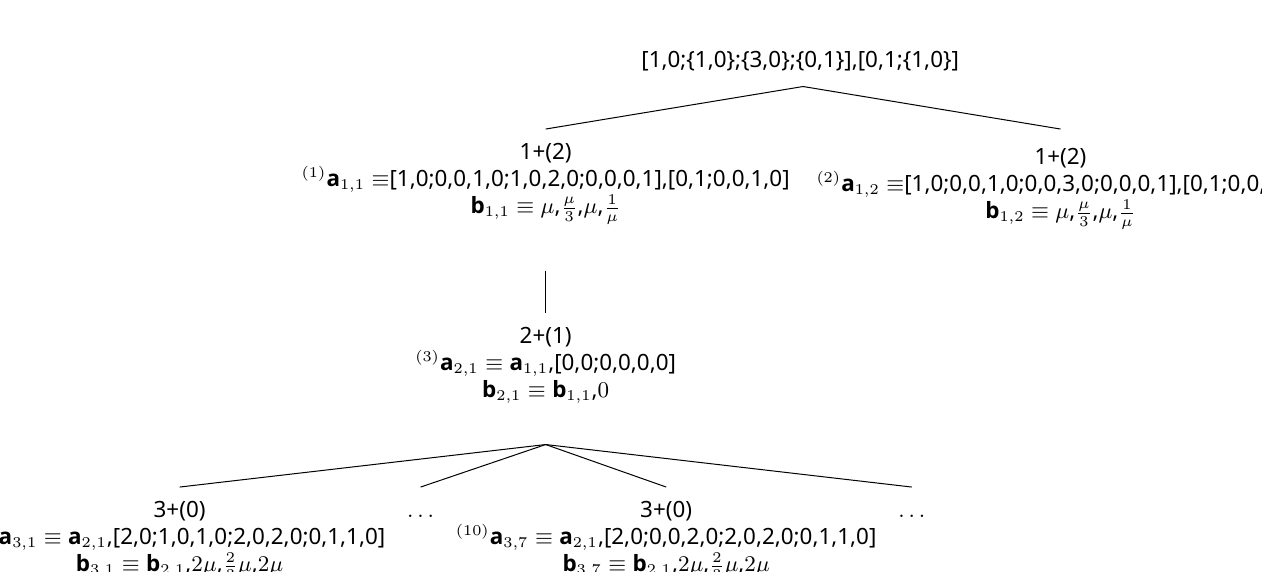
Figure 2. Branch and bound with an admissible heuristic and reverse numerical tie-break for the van der Pol ODE